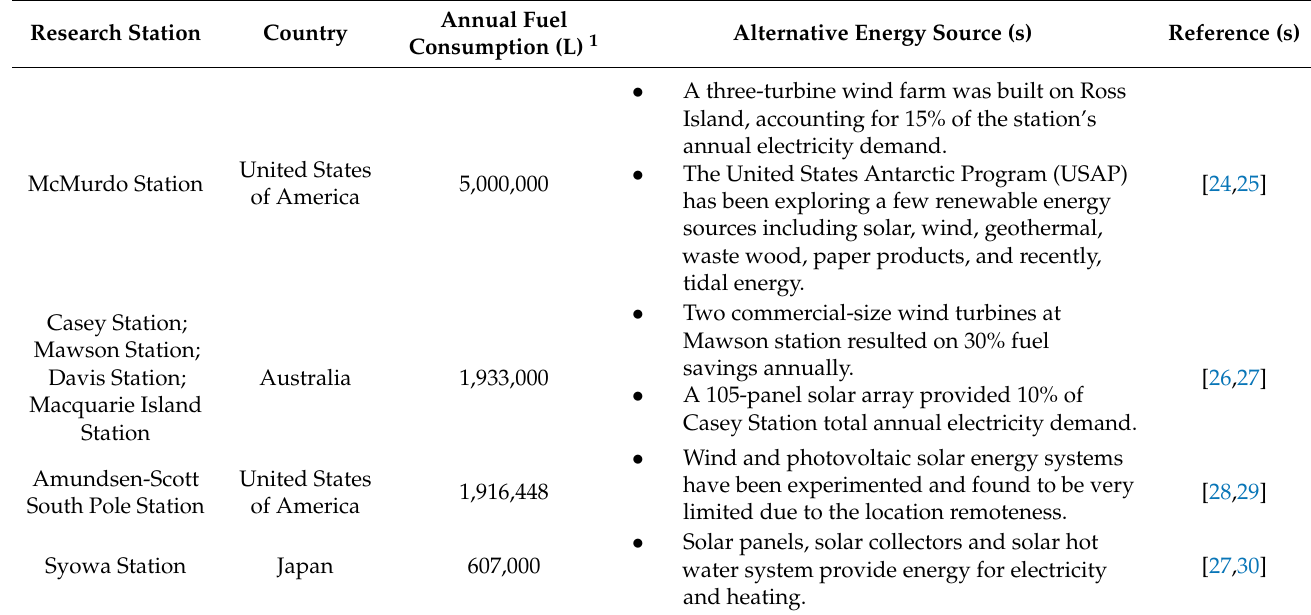
Table 1. Annual fuel consumption in Antarctic research